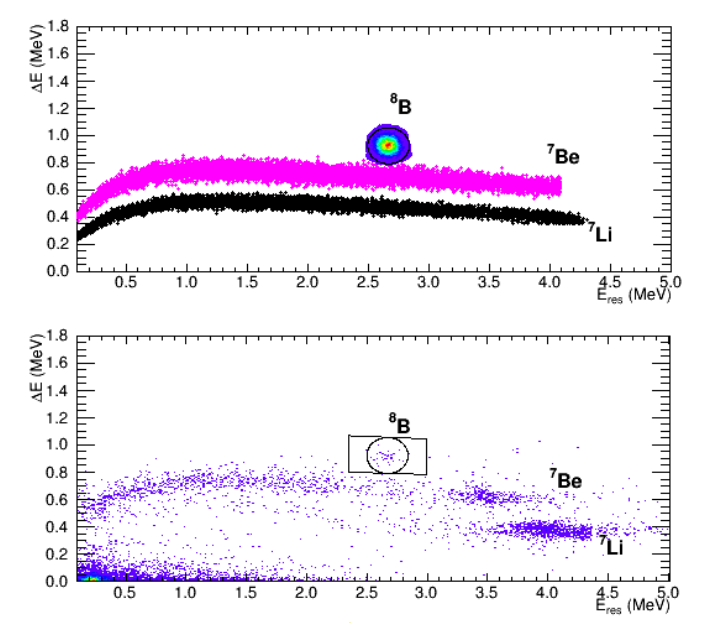
Figure 1. ∆ E − E res matrices of the end detector of ERNA for 7 Be(p ,γ ) 8 B at E b = 675.5 keV. The upper matrix represent the predictions of a Monte Carlo simulation for the di ff erent ion species. The lower matrix the experimental results. Both 7 Li and 7 Be leaky beam ions are visible with long low energy tails. The rectangular region around the elliptical area where the 8 B recoils are expected is used to estimate the